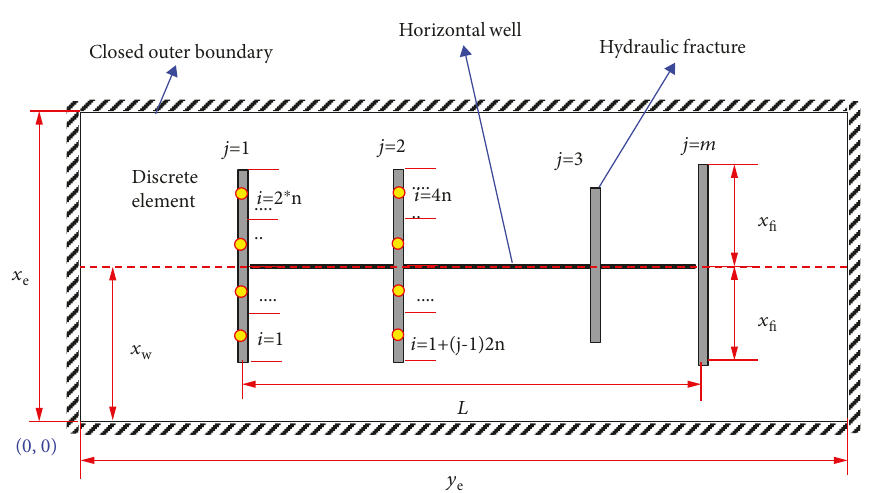
Figure 5: Physical model of a MFHW in a rectangular closed outer-boundary shale gas